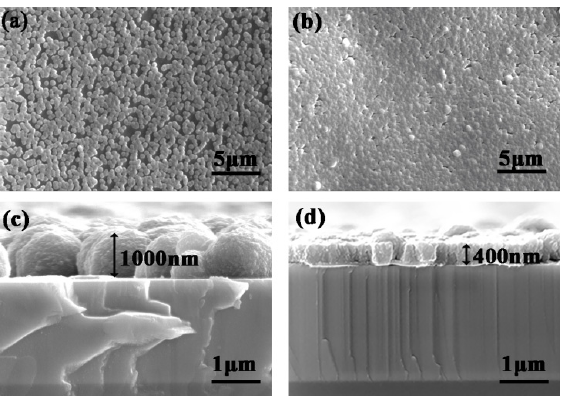
Figure 5. Surface morphology and cross ‐ sectional morphology of the nucleated diamond film on the interlayer of ( a , c ) SiN x (orig) and ( b , d ) SiN x